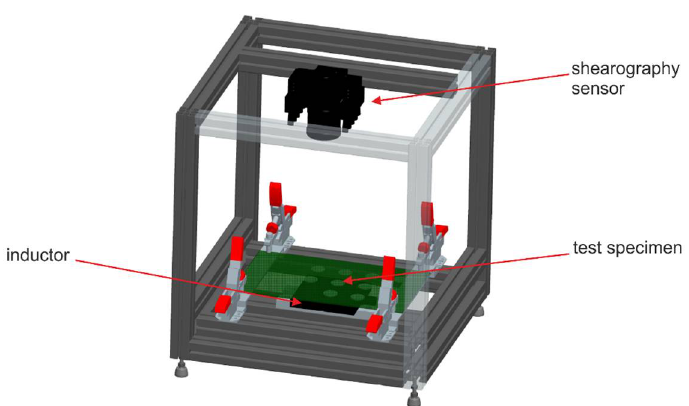
Figure 4. Test setup with shearography sensor, test specimen and inductor.